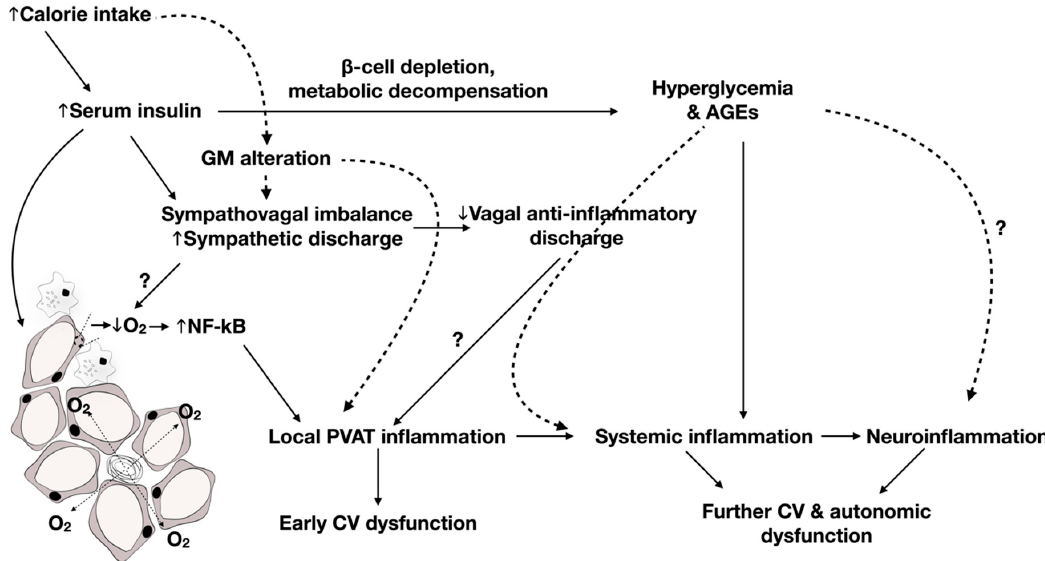
Figure 1. A possible mechanistic and temporal framework for cardiac autonomic neuropathy (CAN) progression in deteriorating metabolic function and the di ff erent interdependent pathways contributing to it. Increased caloric intake induces insulin resistance and alterations in gut microbiota (GM). The resulting hyperinsulinemia and dysbiosis could precipitate adipose inflammation directly or indirectly through sympatho-vagal imbalance. In this context, nuclear factor kappa B (NF- κ B)- induced inflammation results from hypoxia related to perivascular adipose tissue (PVAT) expansion, as well as activation of Toll-like receptors 4 (TLR4) in response to metabolic endotoxemia. Increased proinflammatory sympathetic outflow and diminished anti-inflammatory vagal discharge could further contribute to PVAT inflammation. Later, metabolic decompensation results in β -cell depletion, hyperglycemia, and advanced glycated end products (AGEs), which in turn aggravate the pre-existing localized inflammation, triggering wider changes. Several markers of systemic inflammation have been shown to be associated with deterioration of cardiac autonomic control. Disruption of blood–brain barrier function associated with dysbiosis and systemic inflammation promotes spillage of proinflammatory cytokines to regions of the central nervous system resulting in neuroinflammation and further cardiac autonomic and cardiovascular (CV) dysfunction.